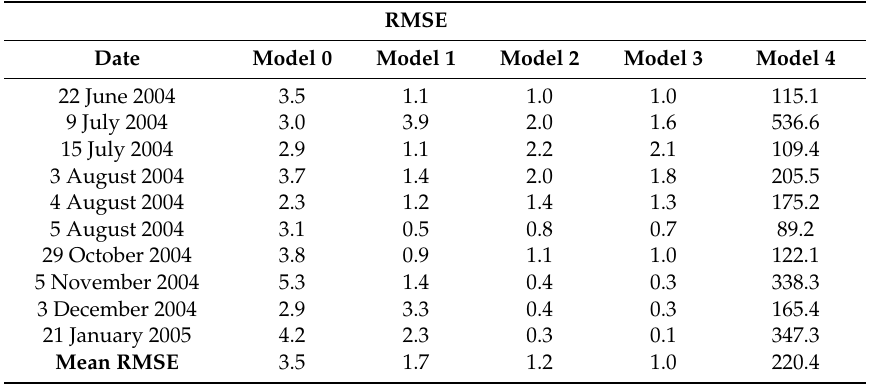
Table 4. The results of the Root Mean Squared Errors (RMSE) used to inspect the di ff erences between the model-calculated fluxes and the field-measured fluxes using various models (Models